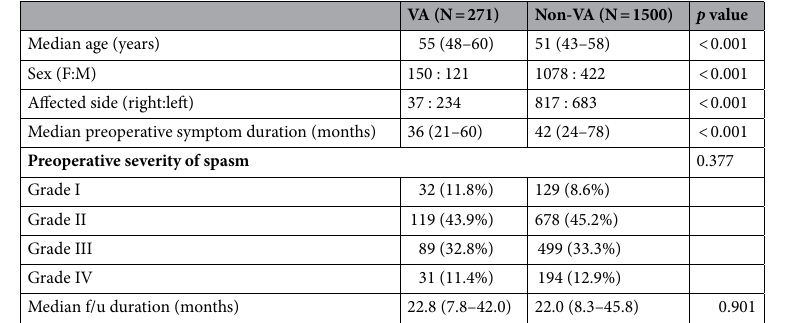
Table 2. Demographics of patients with VA-involved HFS and non-VA-involved HFS. HFS hemifacial spasm, VA vertebral artery, M male, F female, f/u